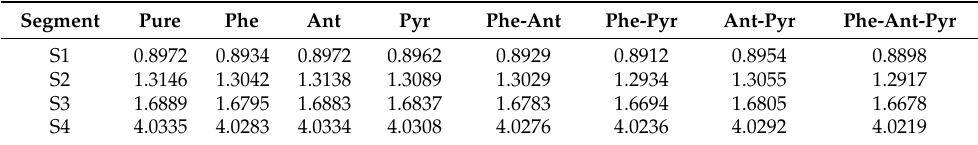
Table 4. Proton chemical shifts (ppm) for SDS without and with the solubilization of different PAHs at the SDS concentration of 120 mM.